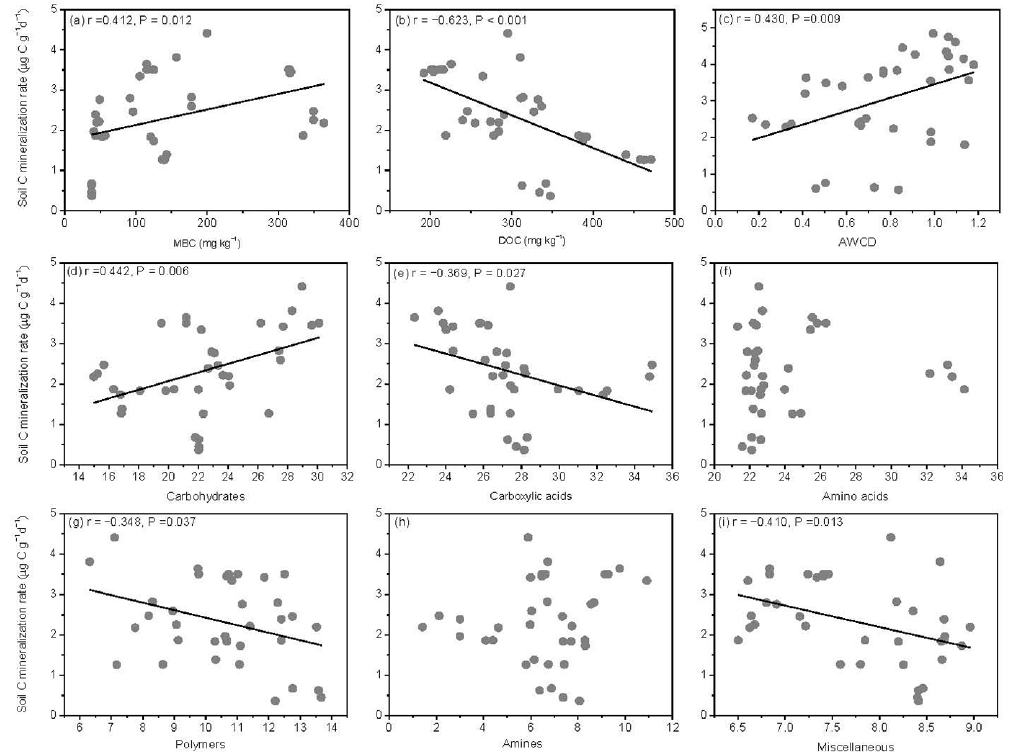
Figure 6. Relationships between soil carbon mineralization rates (µgCg − 1 d − 1 ) and microbial biomass C (MBC), soil dissolved organic C (DOC), average well color development (AWCD), and individual substrate